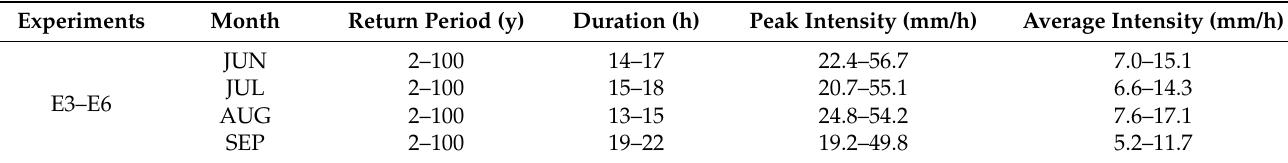
Table 8. Different peak timing rainfall patterns analysis.